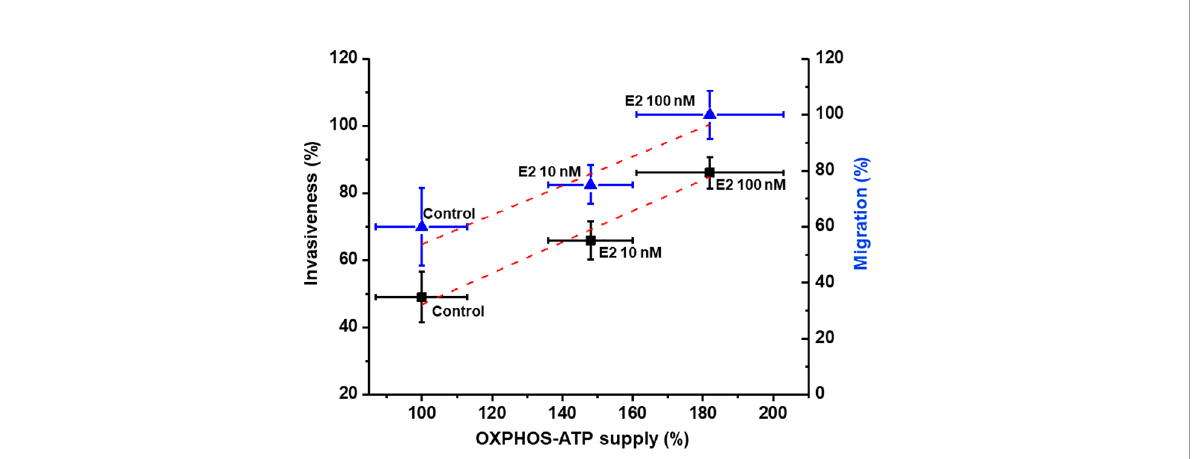
FIGURE 6 Dependence of invasion and migration on OxPhos ATP supply of cells derived from MCF-7 MCTS. Net OxPhos fl ux and metastasis processes were determined in the presence of E2 as described in the Material and Methods section. For cell invasion and migration, the 100 % value for net OxPhos fl ux without E2 was 408 ± 55 pmol O2/s/mg cell protein for cells derived from MCF-7 MCTS. For cell migration, the 100 % value was 290 ± 20 µm displacement for cells derived from MCF-7 MCTS after 24 h. Data represents the mean ± error standard of at least three different preparations.